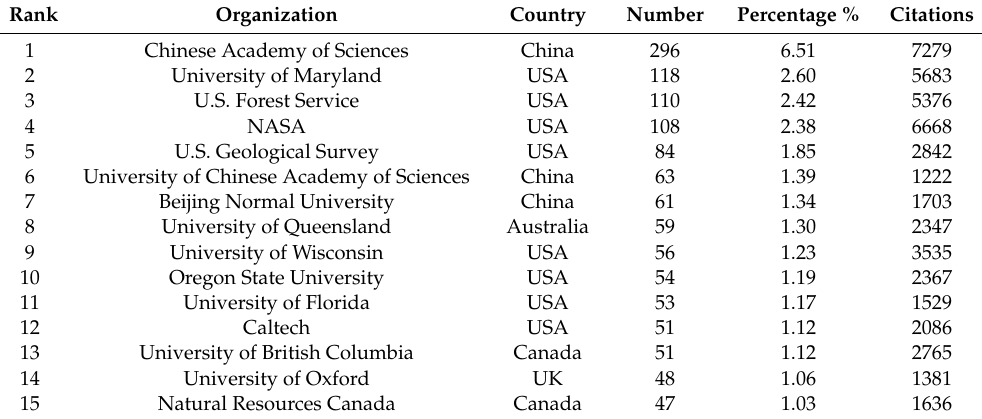
Table 3. Top 15 institutions based on total